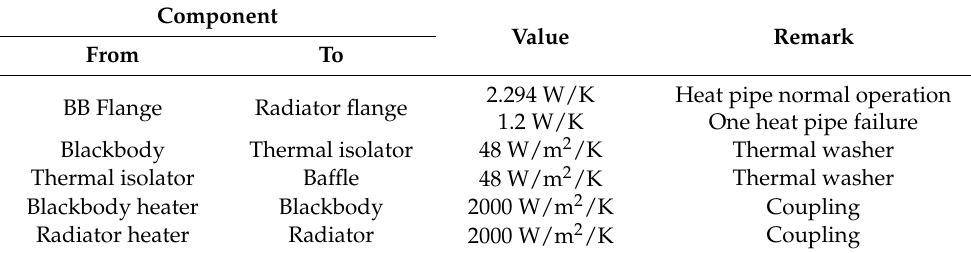
Table 4. Summary of contactor value.